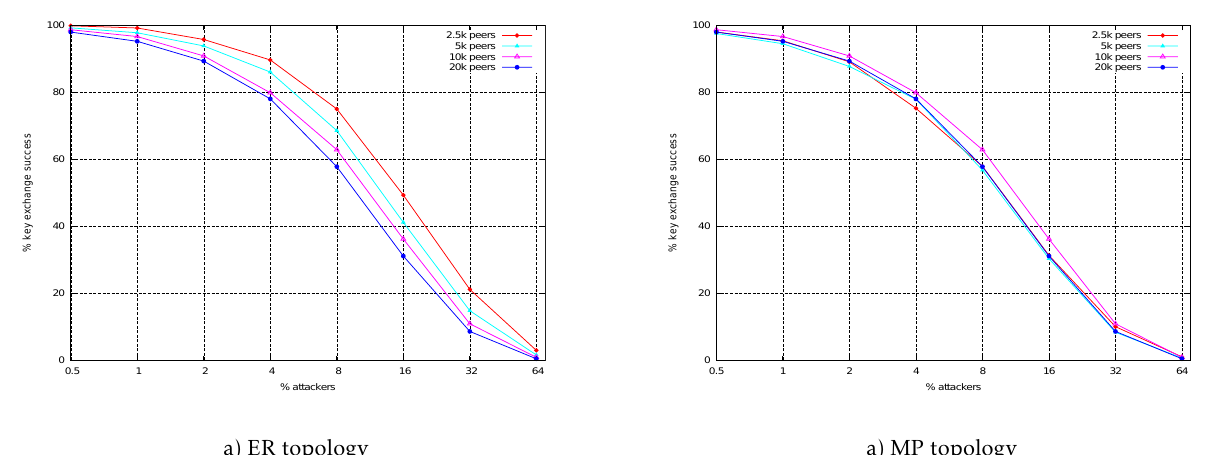
Figure 7. Success rates for different network sizes.